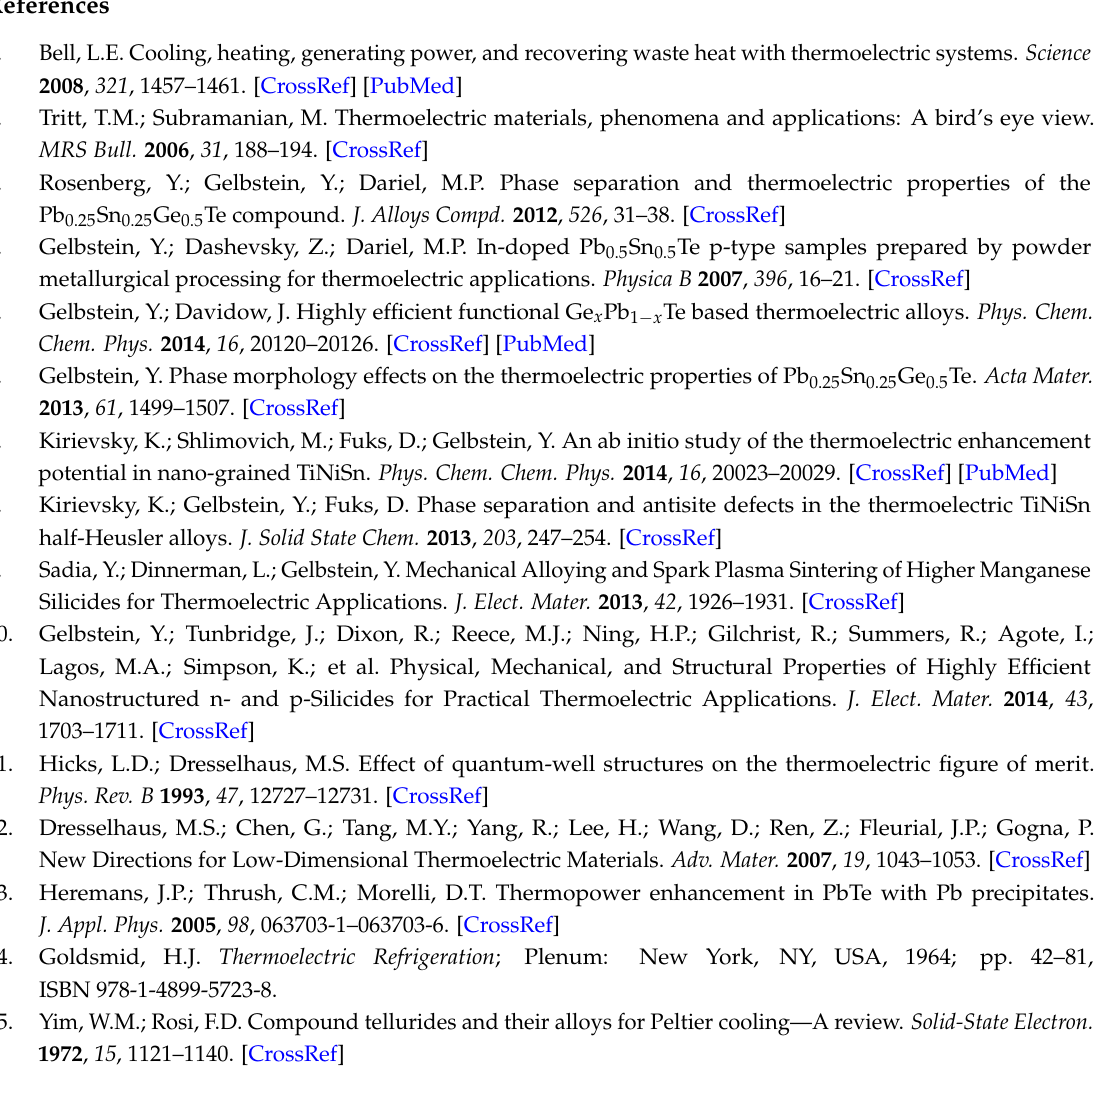
Figure S1: (a) Large crystals grown on top of the template surface blocking the pores in uncleaned template during deposition and (b) Unfilled template with incomplete NW growth as a result as shown in the cross section; Figure S2: (a) A representative sample used for characterization; (b) Peltier module used to heat or cool the sample surface; (c) the Peltier module-copper block assembly used to heat/cool top or bottom surfaces of the